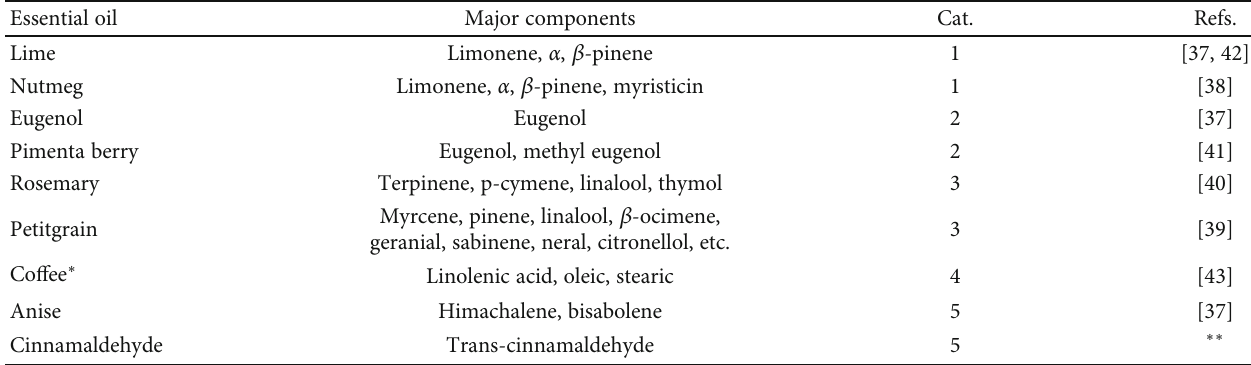
Table 1: Essential oils, their major components, and categorization (Cat.).